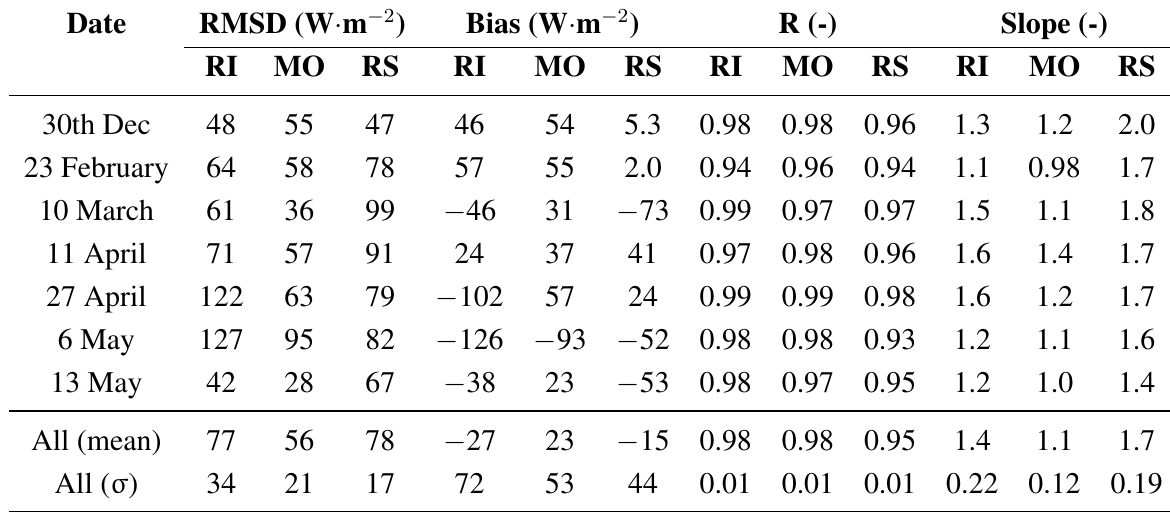
Table 4. Root mean square difference (RMSD), bias, correlation coefficient (R) and slope of the linear regression between the ET simulated at 1-km resolution and the 90-m resolution simulated ET aggregated at 1-km resolution, for data over the Yaqui region, on the seven ASTER overpass dates separately. The Tends used as input to EF_SEB-1S consist of Tends simulated by EBsoil with the RI and MO aerodynamic resistance and the Tends retrieved from 1-km resolution data